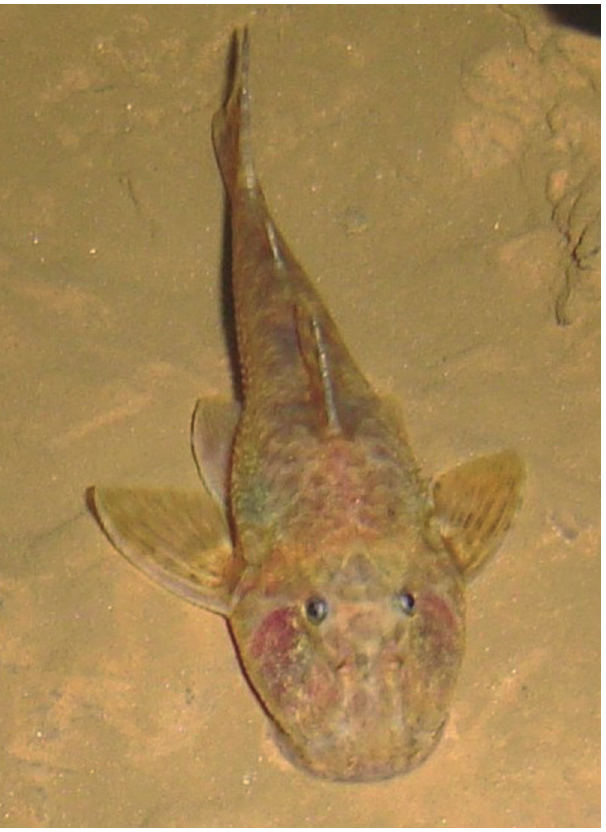
Fig. 1. Slightly depigmented specimen of Isbrueckerichthys alipionis from the riacho Taqueupa, inside Santana Cave in southern São Paulo, Brazil.